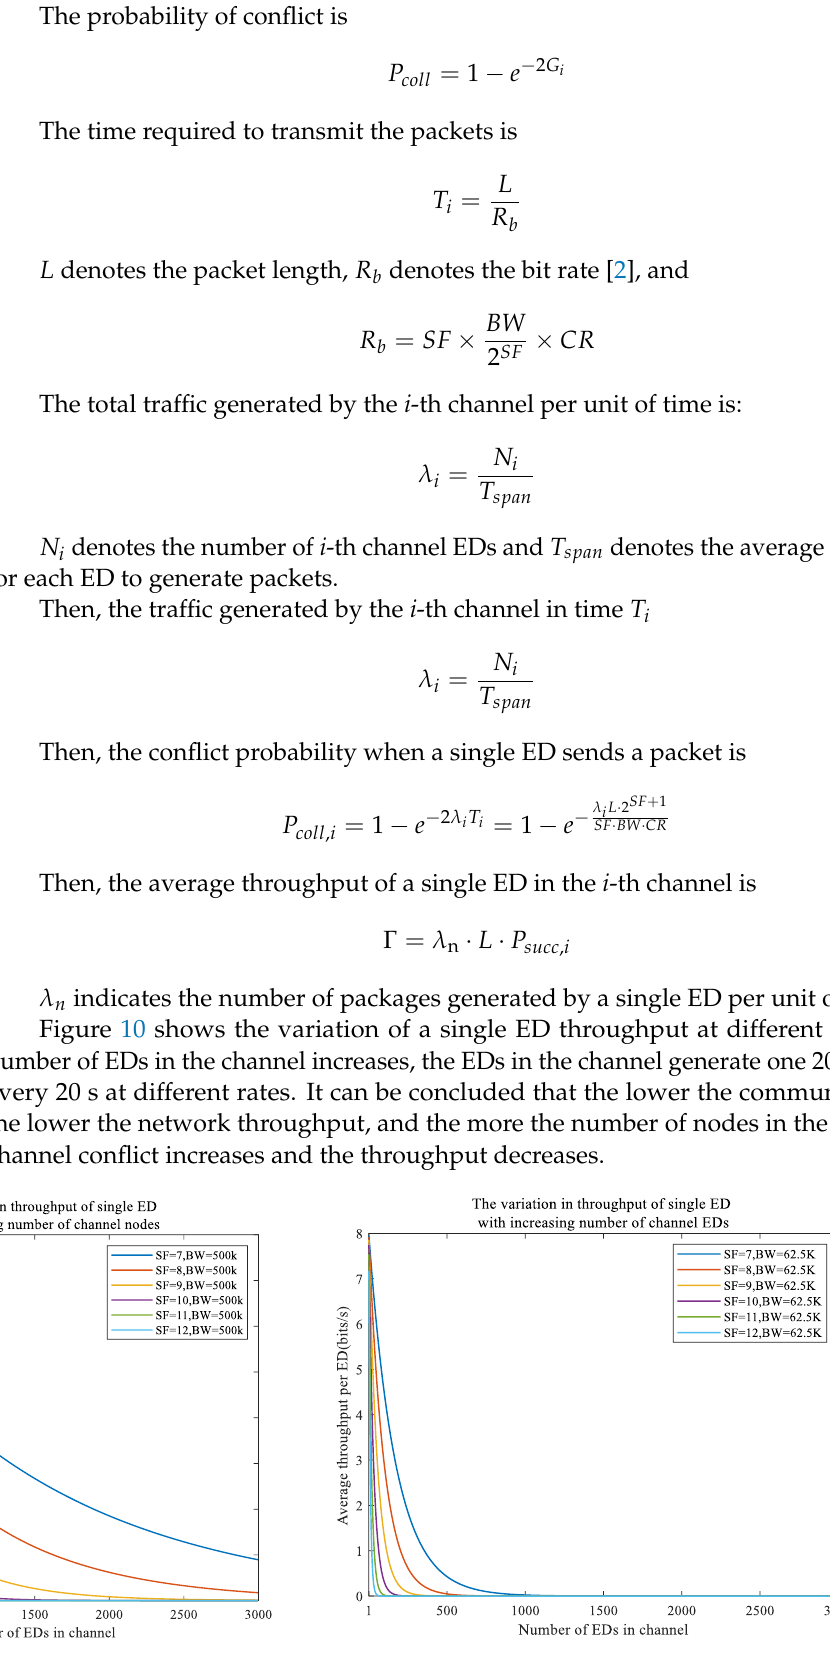
Figure 10. The channel throughput changes with the increase of the number of EDs in the channel.